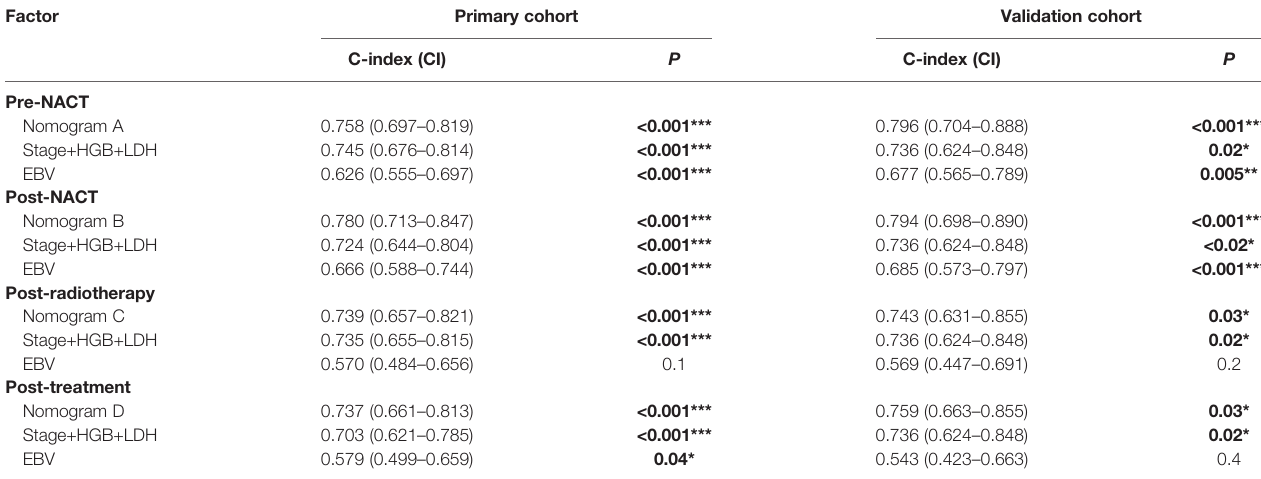
TABLE 4 | The C-indices of nomograms, TNM stage + HGB + LDH, and EBV DNA for the prediction of the progression-free survival (PFS) in the primary cohort and validation cohort . Factor Primary cohort Validation cohort C-index (CI) P C-index (CI)